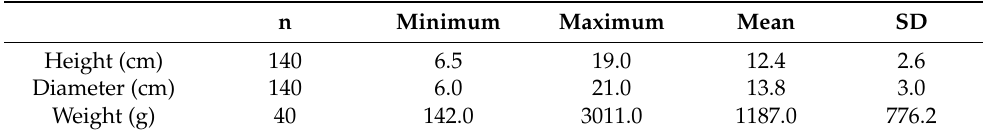
Table 2. Descriptive statistics of pumpkin fruits (n: sample size).